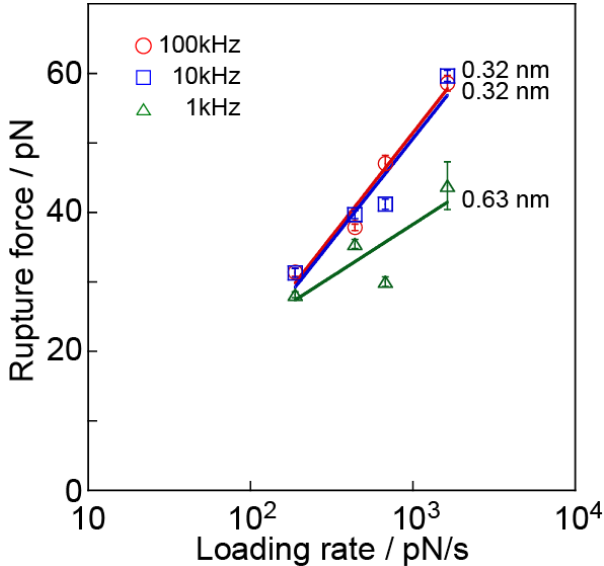
Figure 6. Relationship between the modal rupture forces and the logarithm of the loading rate at sampling rates of 100 kHz, 10 kHz and 1 kHz, which correspond to the values derived from the histograms shown in Figure